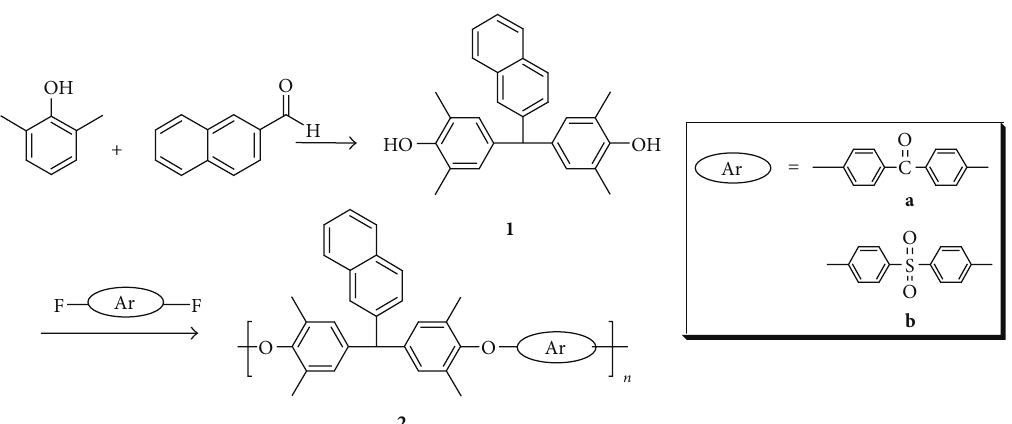
Scheme 1: Syntheses of monomer 1 and polymers 2 .